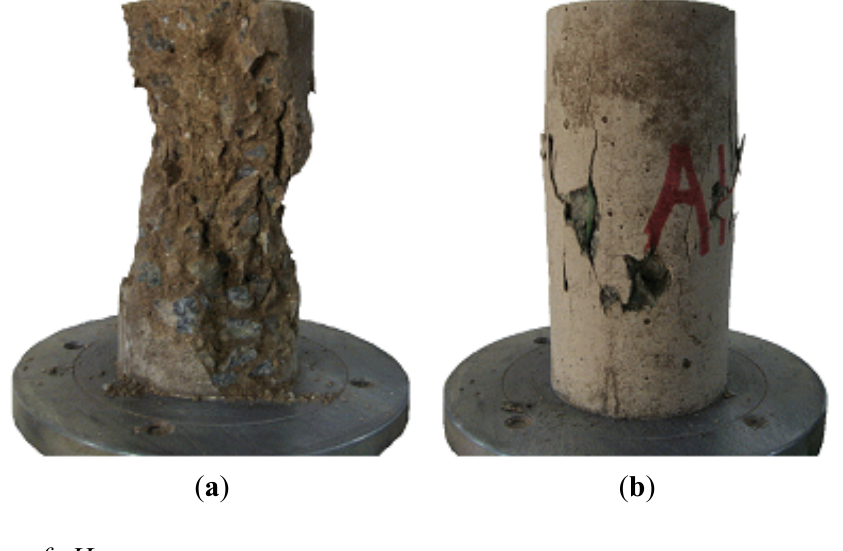
Figure 9. Failure mode of cylindrical Hwangtoh concrete specimens ( a ) Hwangtoh specimen without fibers and ( b ) Hwangtoh specimen with RPET